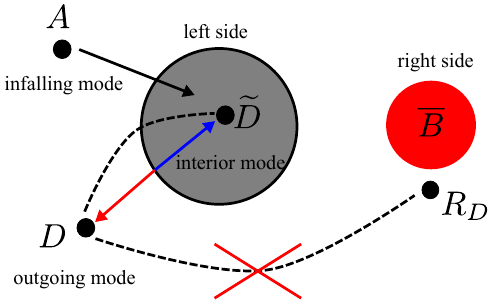
Figure 3 . Backreaction from an infalling observer. The outgoing mode D is entangled with a new mode e D which is dynamically created by A and has nothing to do with r.h.s.